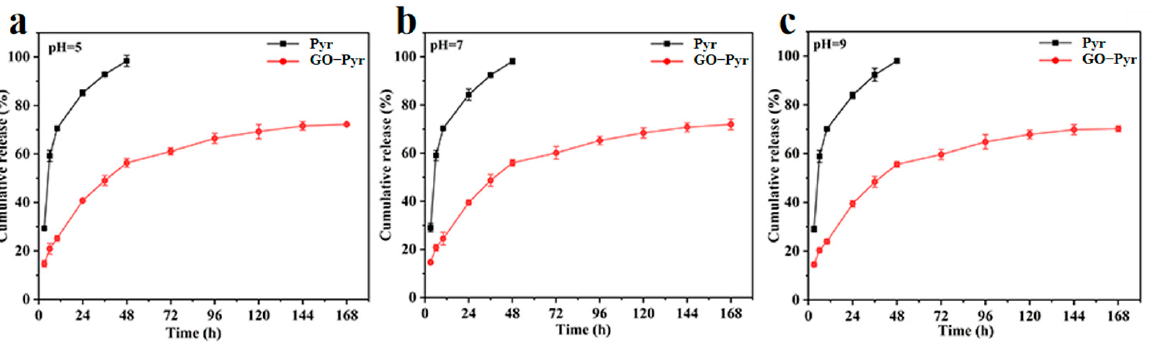
Figure 5. Release kinetics of Pyr and GO–Pyr nanocomposite at pH 5 ( a ), pH 7 ( b ) and pH 9 ( c ). Data are mean of cumulative release rate ± SE ( N = 3). Table 2. Kinetic parameters of Pyr release from GO–Pyr nanocomposite at pH 5.0, 6.0 and 7.0. Conditions